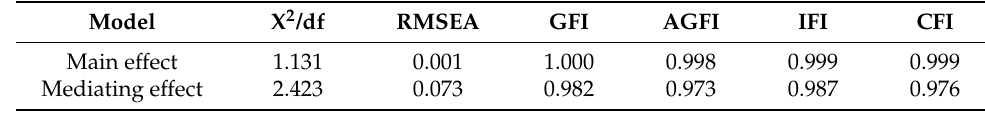
Table 6. Descriptive statistics.